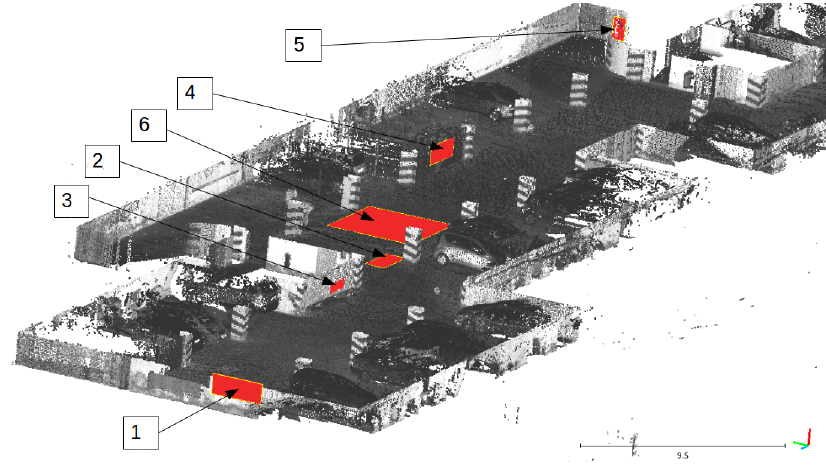
Figure 11. Location of planar targets that are evaluated in Table 2. Table 2. The evaluation of accuracy and precision of planar targets detection using Livox Mid-40 with planar reflector. Locations of planar targets are shown in Figure